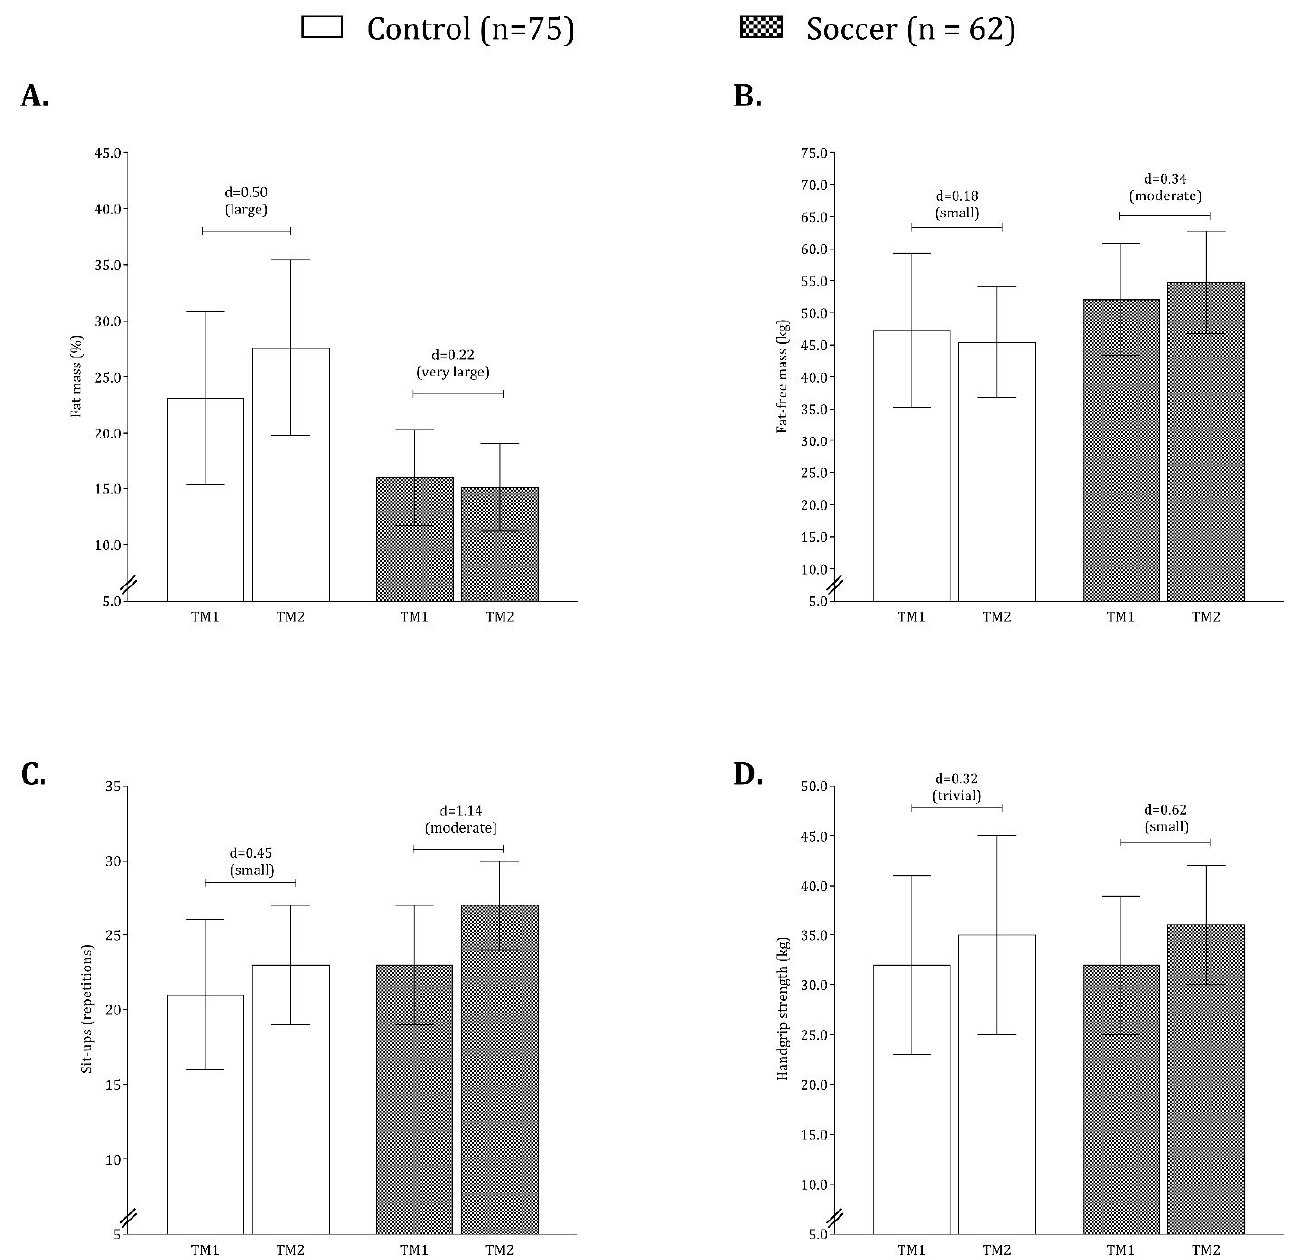
Figure 2. Intraindividual changes (TM1 and TM2) between groups for fat mass ( A ), fat-free mass ( B ), sit-ups ( C ), and handgrip strength ( D ).